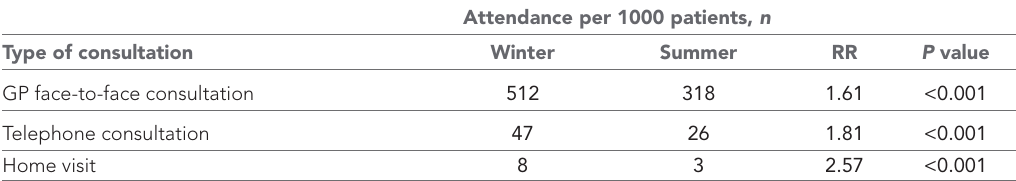
Table 5 Comparison of types of GP